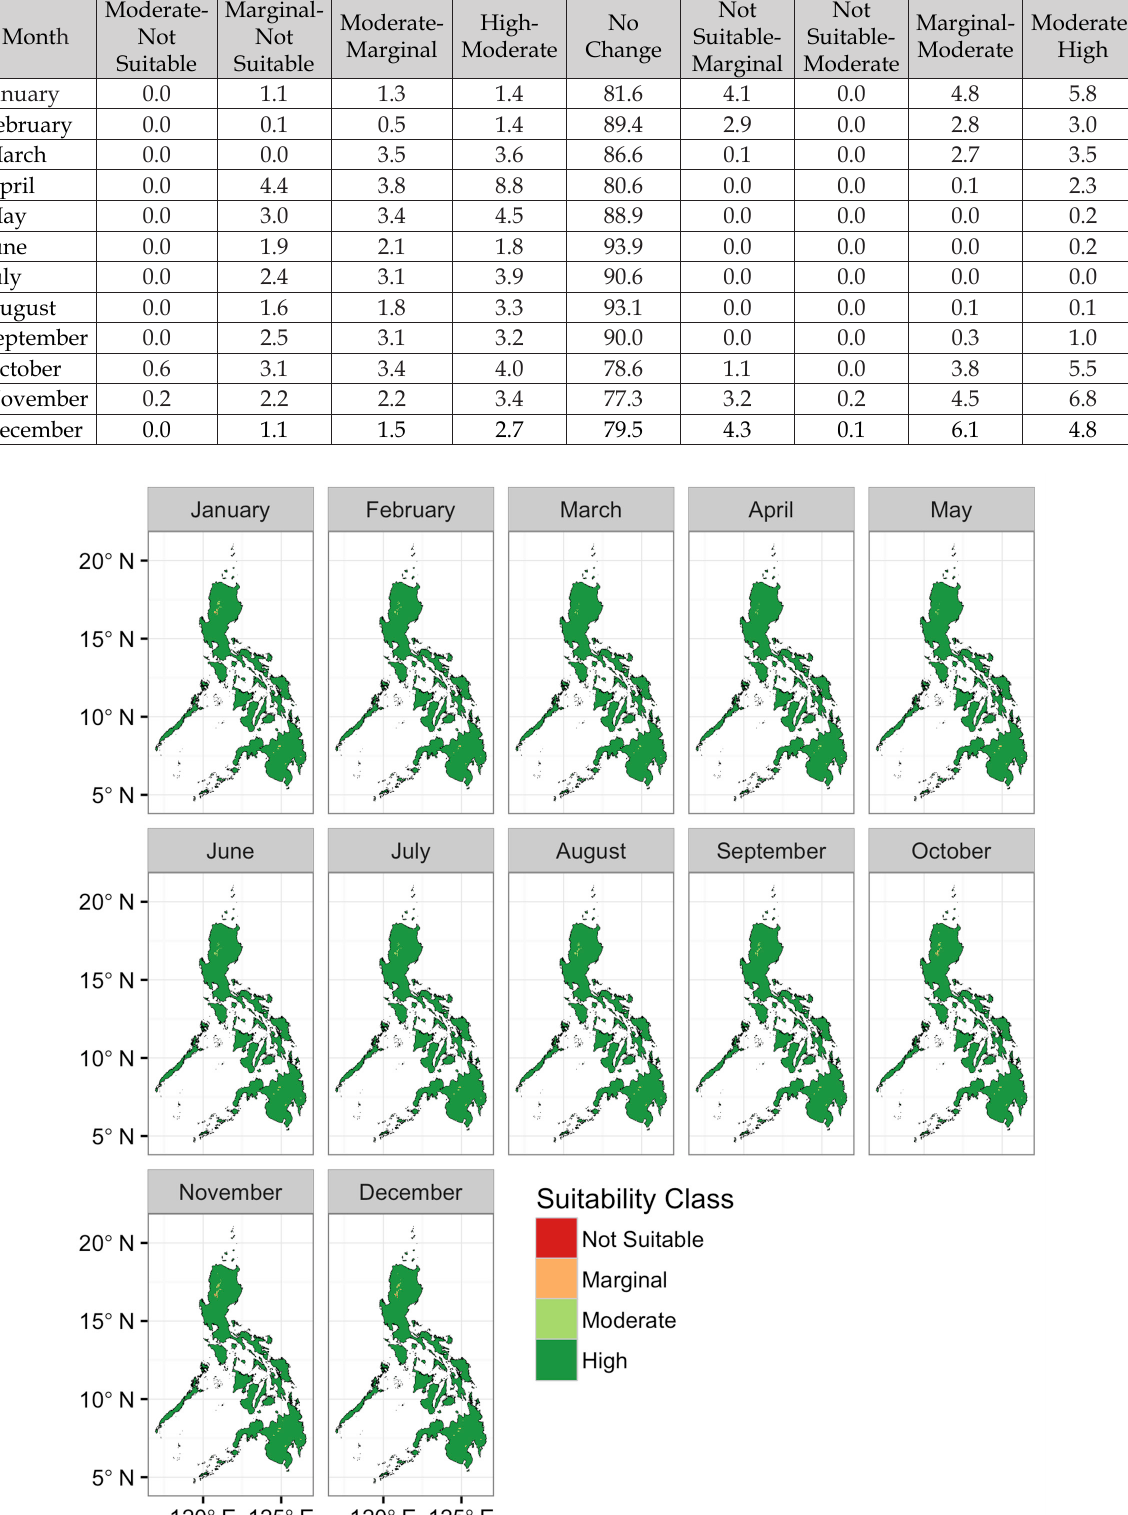
Table 4. Monthly proportion (%) of changes in climatic suitability due to change in rainfall under future cli - mate